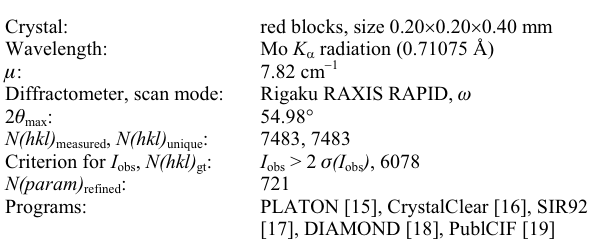
Table 1. Data collection and